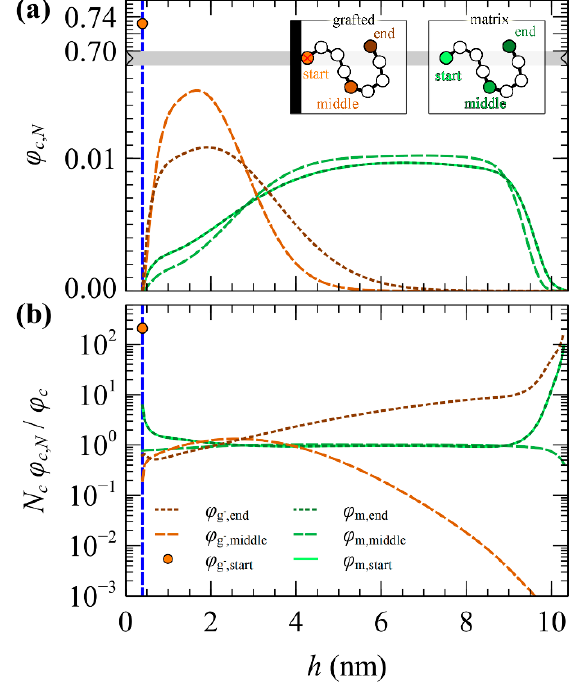
Figure 7. ( a ) Reduced density profiles of starting, middle, and end segments of grafted and matrix chains; ( b ) the corresponding normalized distributions via Equation (32). The insets illustrate, schematically, the starting, middle, and end segments of grafted and matrix chains. The profiles were obtained from a perfectly wetted SiO 2 /PS GMV system (see Table 1 in Ref. [27]) with σ g − = 0.4 nm –2 , N g − = 50, N m = 100, and L = 10 nm.